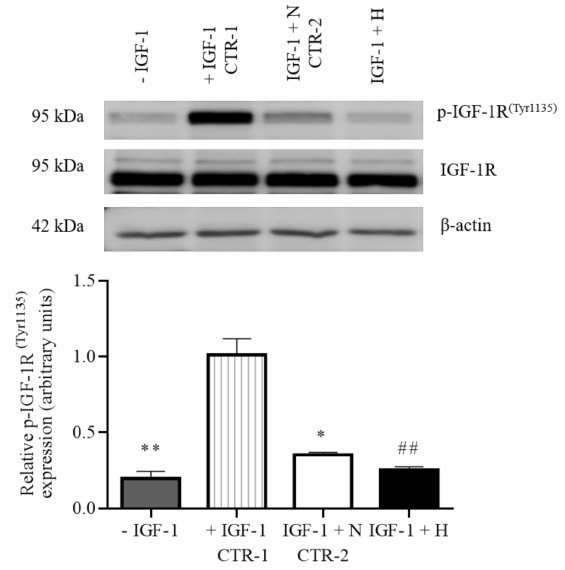
Figure 5. Hypoxia treatment inhibits IGF-1R activity in decidualized primary HESCs. CM was collected from decidualized primary HESCs treated under normoxic (N) (incubator air) or hypoxic (H) (1% O 2 ) conditions for 72 h and buffer exchanged with high glucose DMEM media. Equal total IGFBP-1 (50 ng) in the buffer exchanged media were incubated with recombinant human IGF-1 (1 ng) and used to treat P6 cells in culture. P6 cells were lysed and Western blotting was performed (equal loading, 30 µ g protein) to determine changes in IGF-1-induced IGF-1R autophosphorylation (Tyr1135) compared to IGF-1 Control 1 (CTR-1). Media with IGFBP-1 (50 ng) from primary decidualized (HESCs) cells under normoxia was considered as Control 2 (CTR-2). The Western blot data are summarized in the bar graphs ( n = 4). Data was first normalized to total IGF-1R followed by β -actin. Values are given as mean + SEM. *, p < 0.05; ** or ## , p = 0.001–0.05 versus control as per